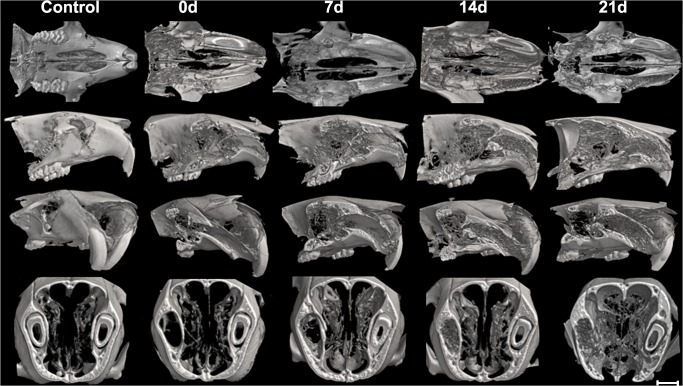
Micro-computed tomography (μCT) analysis of bone healing process kinetics in mice.Samples from 8-week-old male wild-type (WT) C57BL/6 mice were scanned with the μCT System (Skyscan 1174; Skyscan, Kontich, Belgium): control (maxilla without extraction) and at 0, 7, 14 and 21 days post tooth to evaluate the kinetics of the bone healing process. Images were reconstructed using the NRecon software and three-dimensional images obtained with the CT-Vox software. From top to bottom, the sectioned maxilla are represented at the transverse (horizontal); sagittal; sagittal with inclination and transaxial planes.